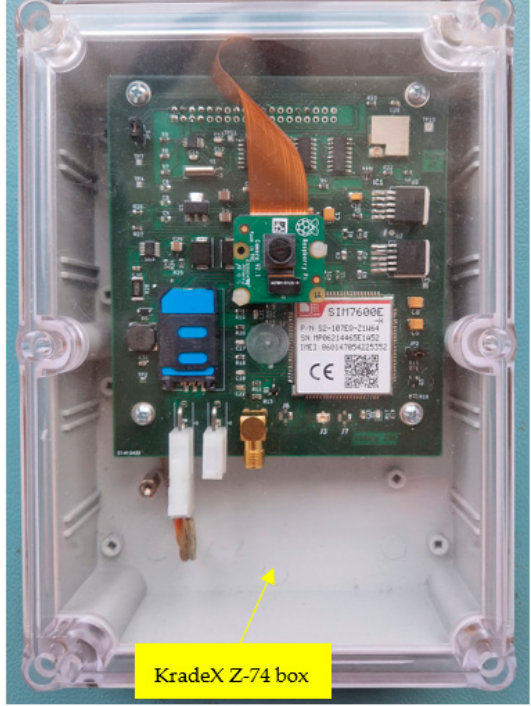
Figure 8. Sensing device case with transparent cover. The battery is placed behind the printed circuit board (not visible).